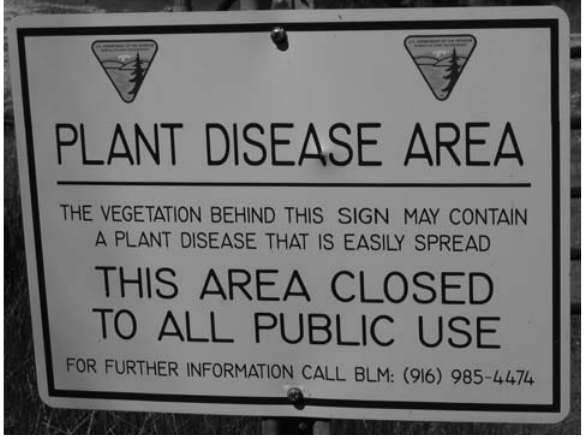
Fig 4. Population genetics information helps